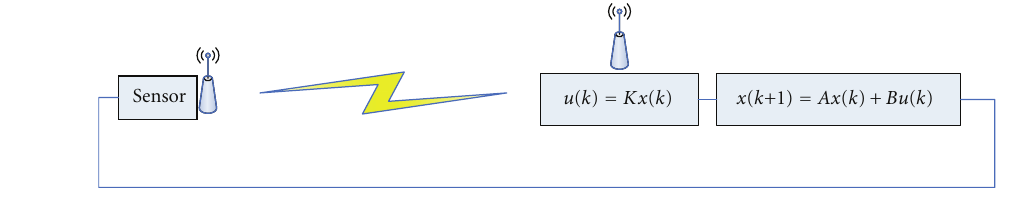
Figure 1: System configuration.